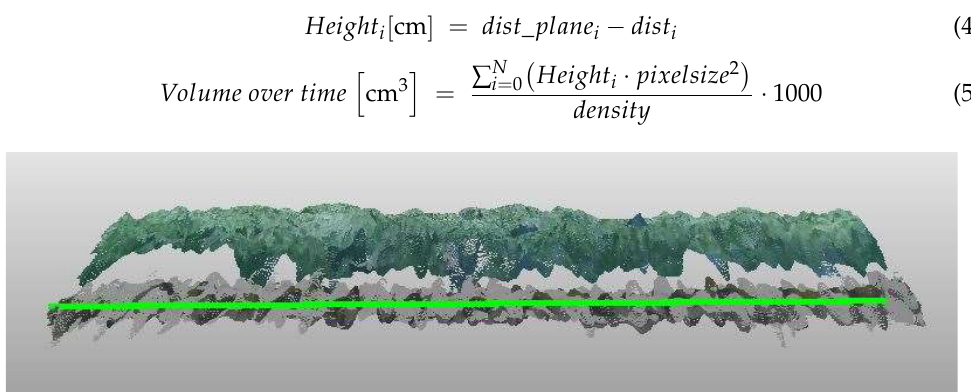
Figure 6. Side view of point cloud within green the fitted ground plane using RANSAC [58] to determine the height. At the bottom the plants at the start date and above the plants at the day of harvest.